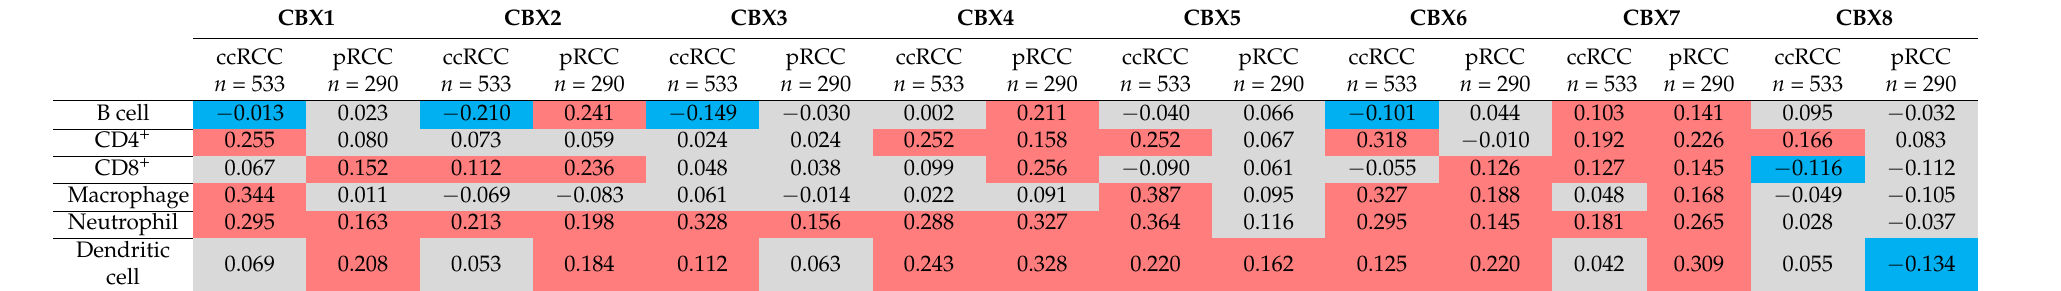
Table 2. Spearman’s correlation between CBXs expression and the abundance of immune cell infiltration (TIMER2.0) in ccRCC and